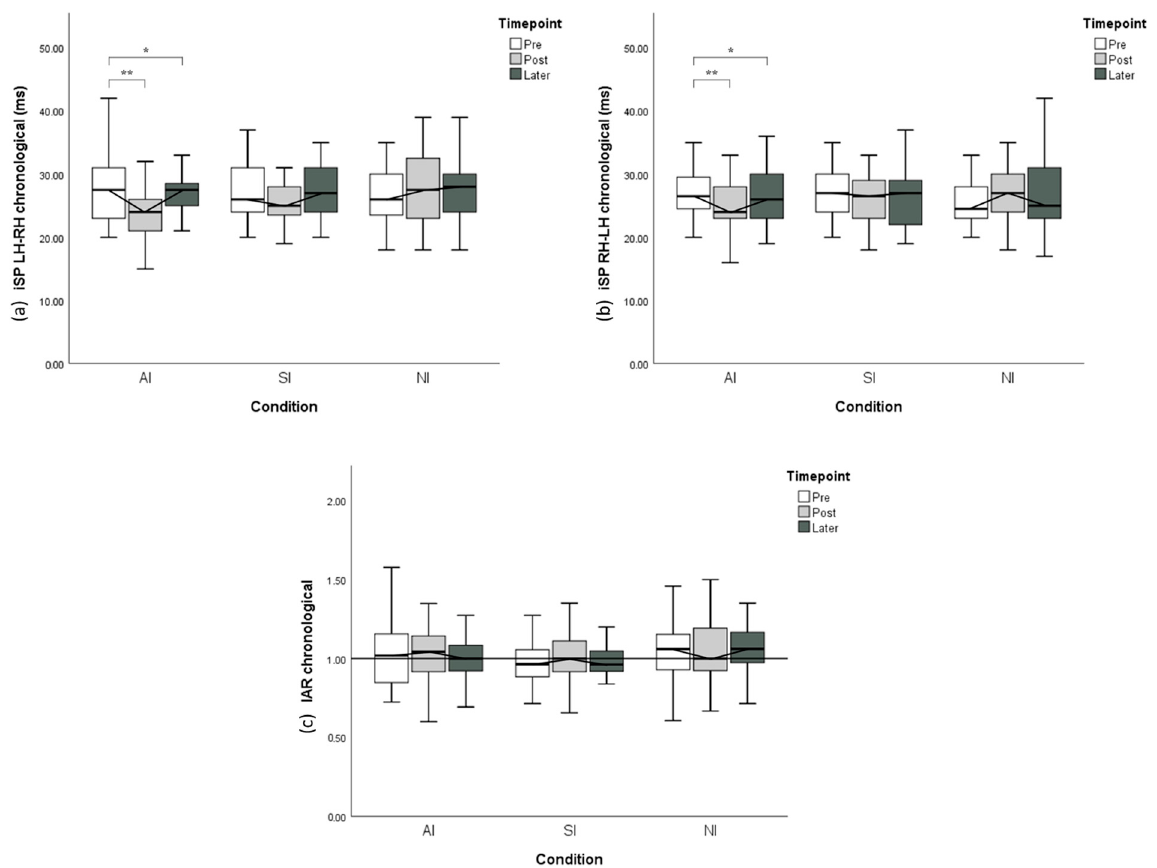
Figure 5. Chronological variation of the ipsilateral silent period (iSP) from plastic change analysis. ( a ) iSP LH–RH with different conditions and time points. ( b ) iSP RH-LH with different conditions and time points. ( c ) Interhemispheric asymmetry ratio IAR with different conditions and time points. The y-axis of A and B displays iSP duration, with shorter iSP duration indicating less interhemispheric inhibition. The y-axis of C indicates IAR computed from the corresponding iSP. Error bars represent 95% CI. * p < 0.05; ** p < 0.01.